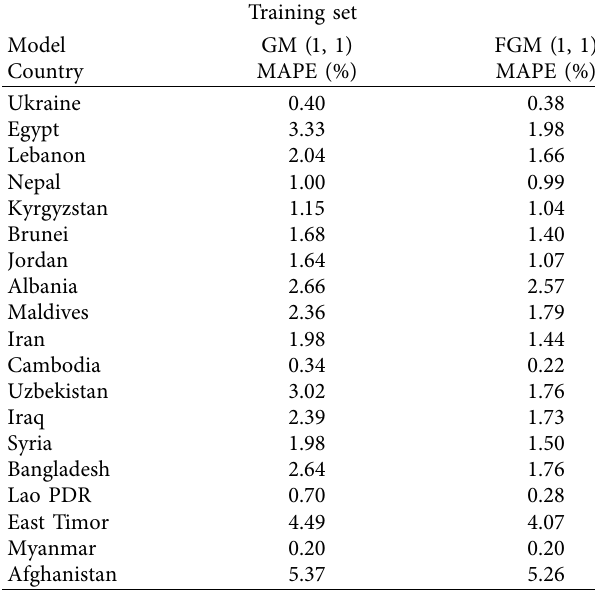
Table 4: MAPE values of the training set.